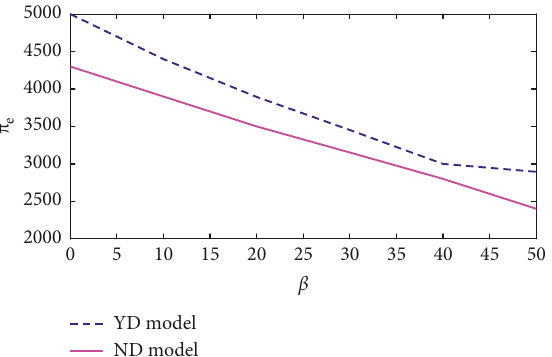
Figure 3: The impact of β on the e-commerce platform’s profit under the ND model and YD model.